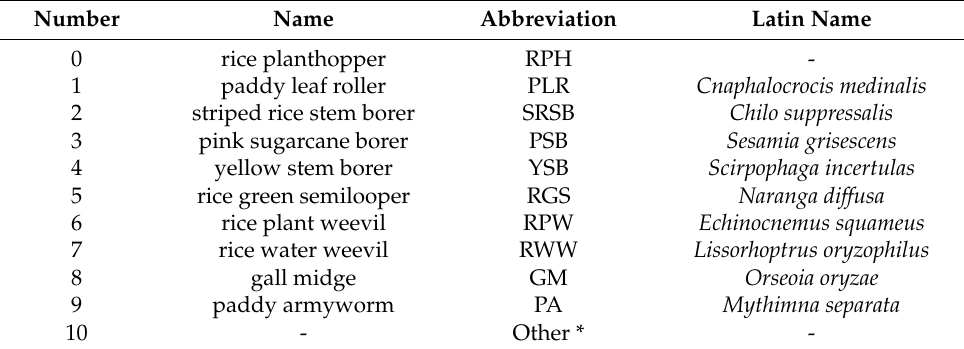
Figure 2. Locations of study areas and light traps. Table 1. The main rice pests captured by the light